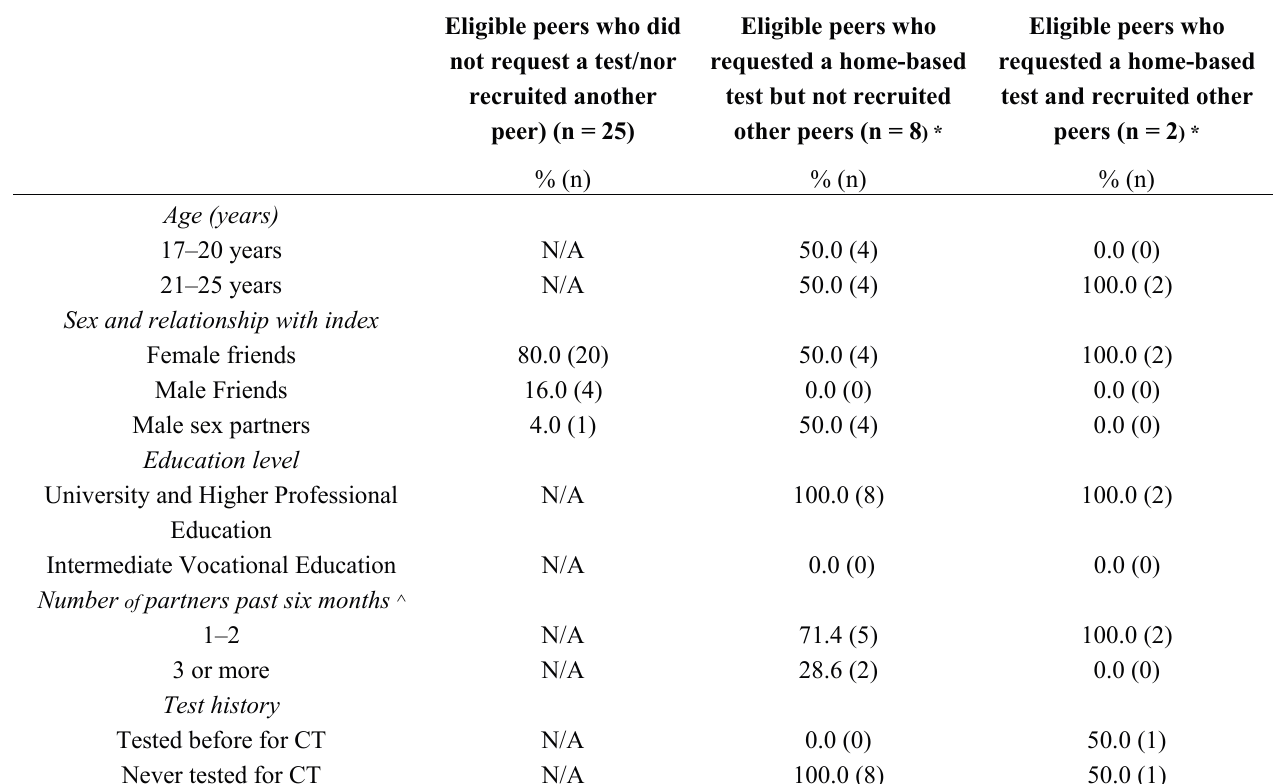
Table 2. Characteristics of eligible